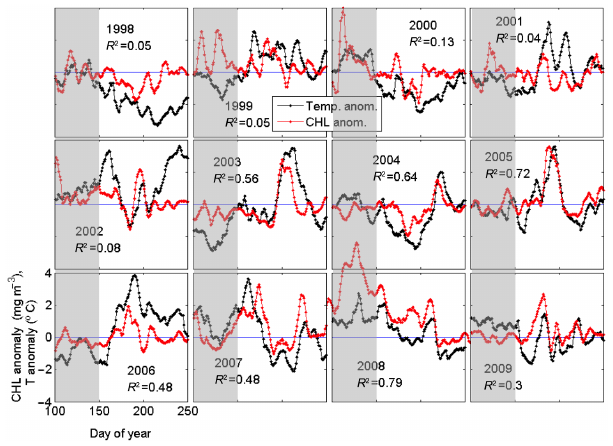
Figure 8. Time series of the Chl a and SST anomalies with respect to their climatologies, over the Central Baltic. The reference value 0 is also displayed. Shaded areas indicate the part of the time series not used for the computation of the cross-correlation coefficient, which is indicated on each year. Full size plots of individual years can be found in the